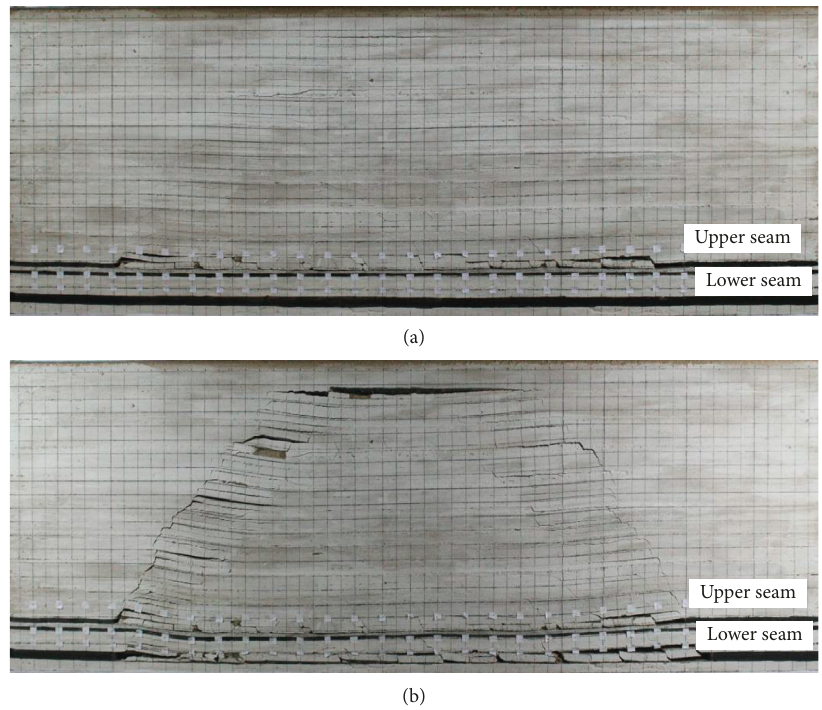
Figure 4: Physical modelling results after extraction of (a) upper and (b) lower panels in Case